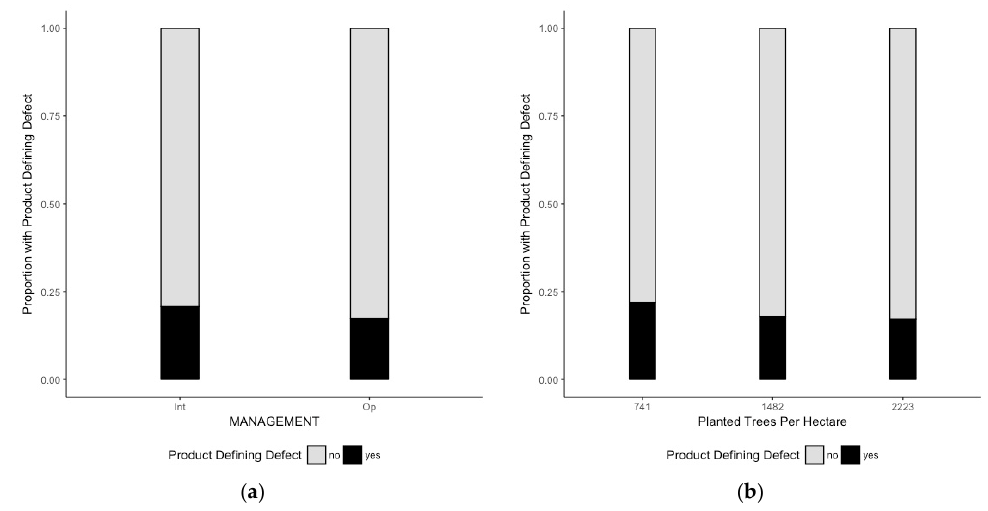
Figure 3. Product-defining defect proportion by management intensity ( a ) and planting density ( b ) across six installations of PMRC SAGS Culture × Density non-thinned sites (Int = intensive, Op. = operational).